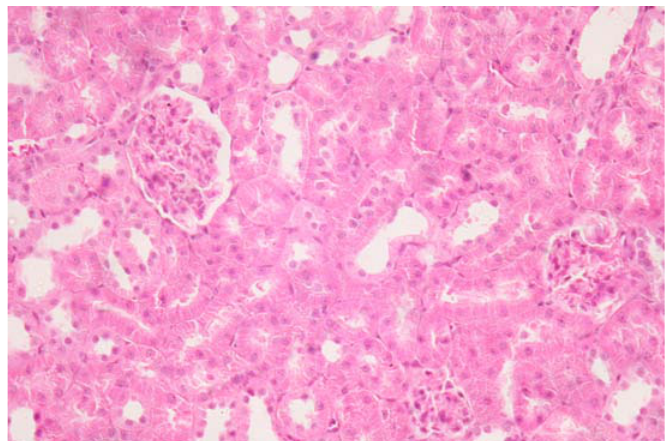
FIGURE 4 - Photomicrograph of kidney from a sildenafil group rat, showing minor cellular necrosis and intense dilation of tubular lumen. Hematoxylin-eosin stained section, magnification 200x